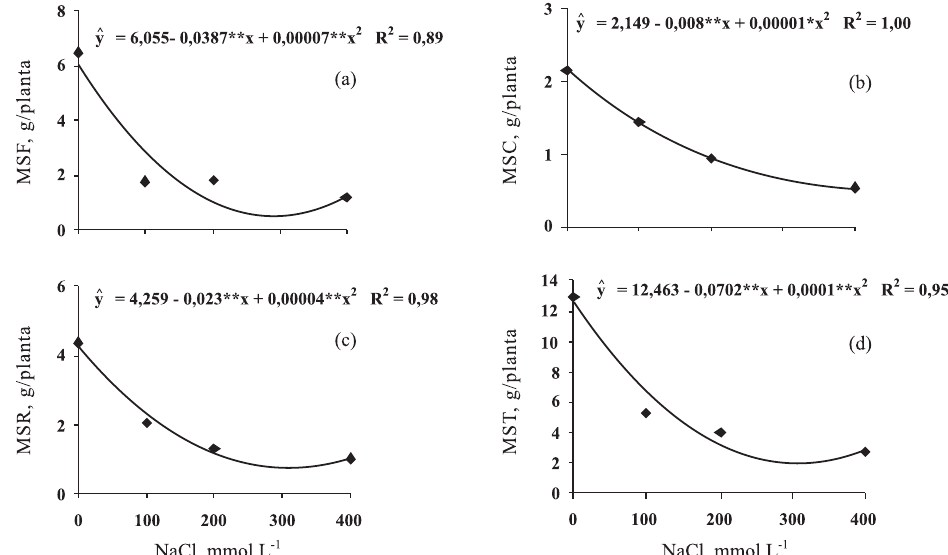
Figura 2. Incremento de matéria seca das folhas (MSF) (a), matéria seca dos caules (MSC) (b), matéria seca das raízes (MSR) (c) e matéria seca total (MST) (d) de mudas de gliricídia em função das concentrações crescentes de NaCl na solução